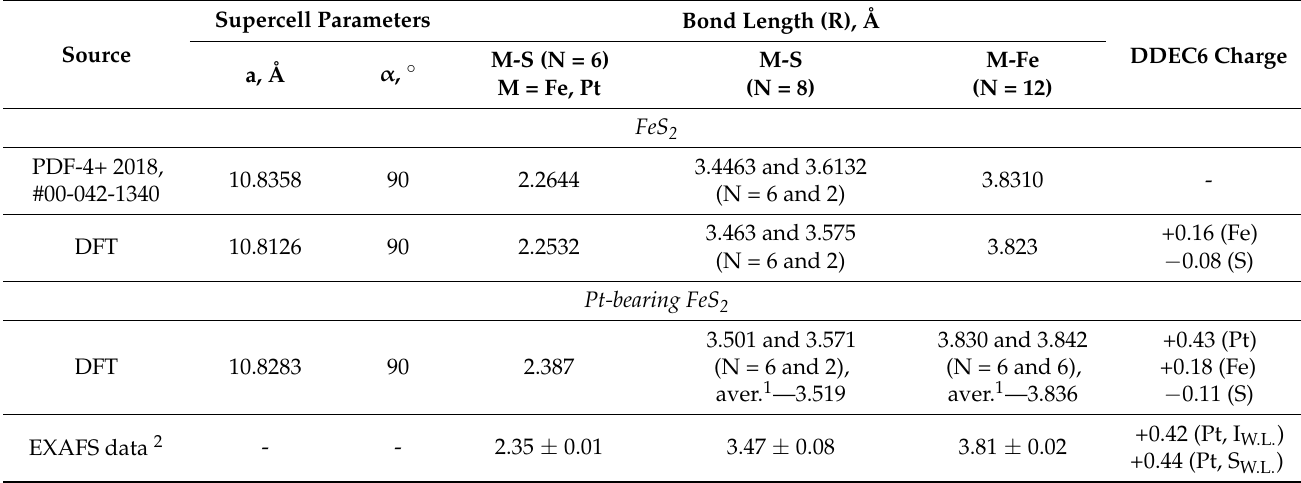
Table 4. Results of determination of the charge state of atoms in pure and Pt-bearing pyrite. Supercell Parameters Bond Length (R), Source